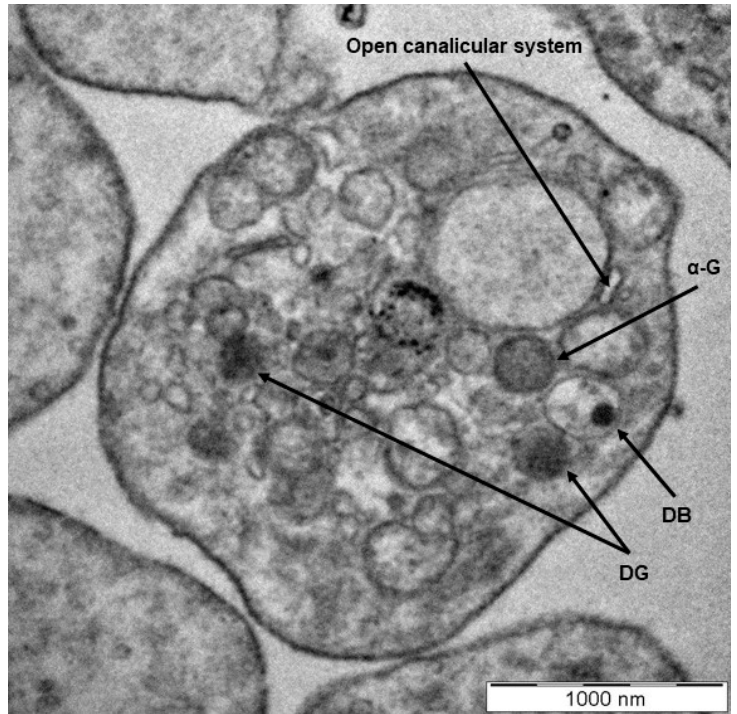
Figure 1. A transmission electron microscopy image showing the morphology of a healthy platelet. The discoid, compacted structure indicates a platelet at rest with clear visualization of the dense granules (DG) and dense bodies (DB), α -granules ( α -G), and an open canalicular system (scale indicates 1000 nm) [7–12]. Cells 2021 , 10 , x FOR PEER REVIEW